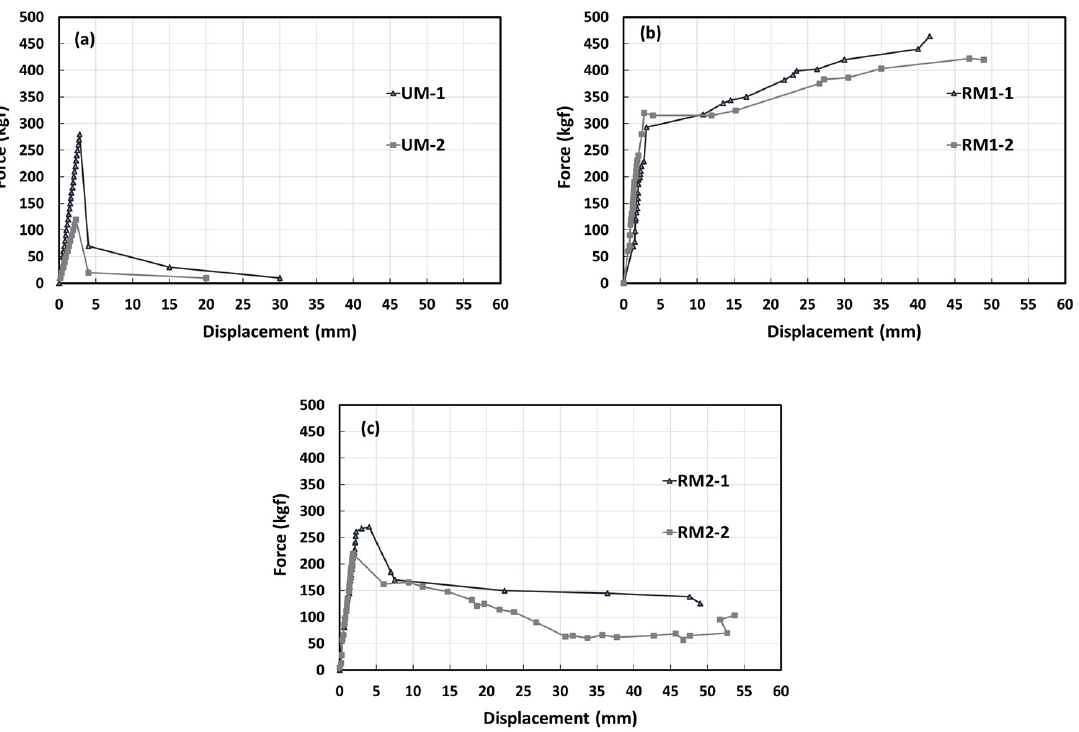
Figure 19. Force–displacement curves of three masonry models under shear test: ( a ) unreinforced masonry, ( b ) retrofitted masonry using 2.88% of bamboo, and ( c ) retrofitted masonry using 1.44% of bamboo.